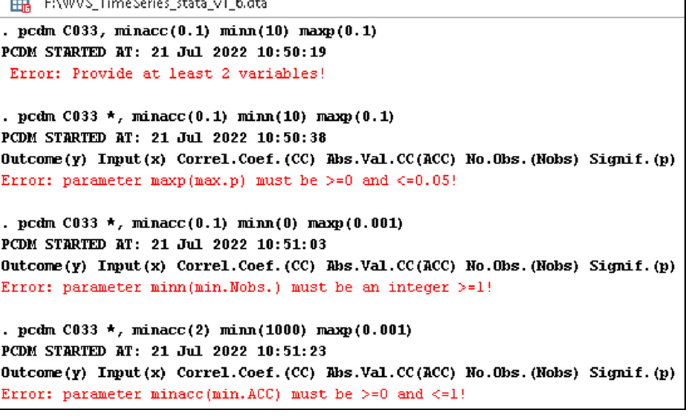
Figure A1. Errors when not providing enough variables or exceeding the minimum/maximum thresholds of those three PCDM parameters. Notes: The same as the first two in Figure 2.